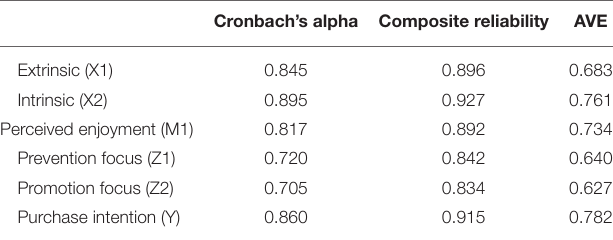
TABLE 2 | Reliability and convergent